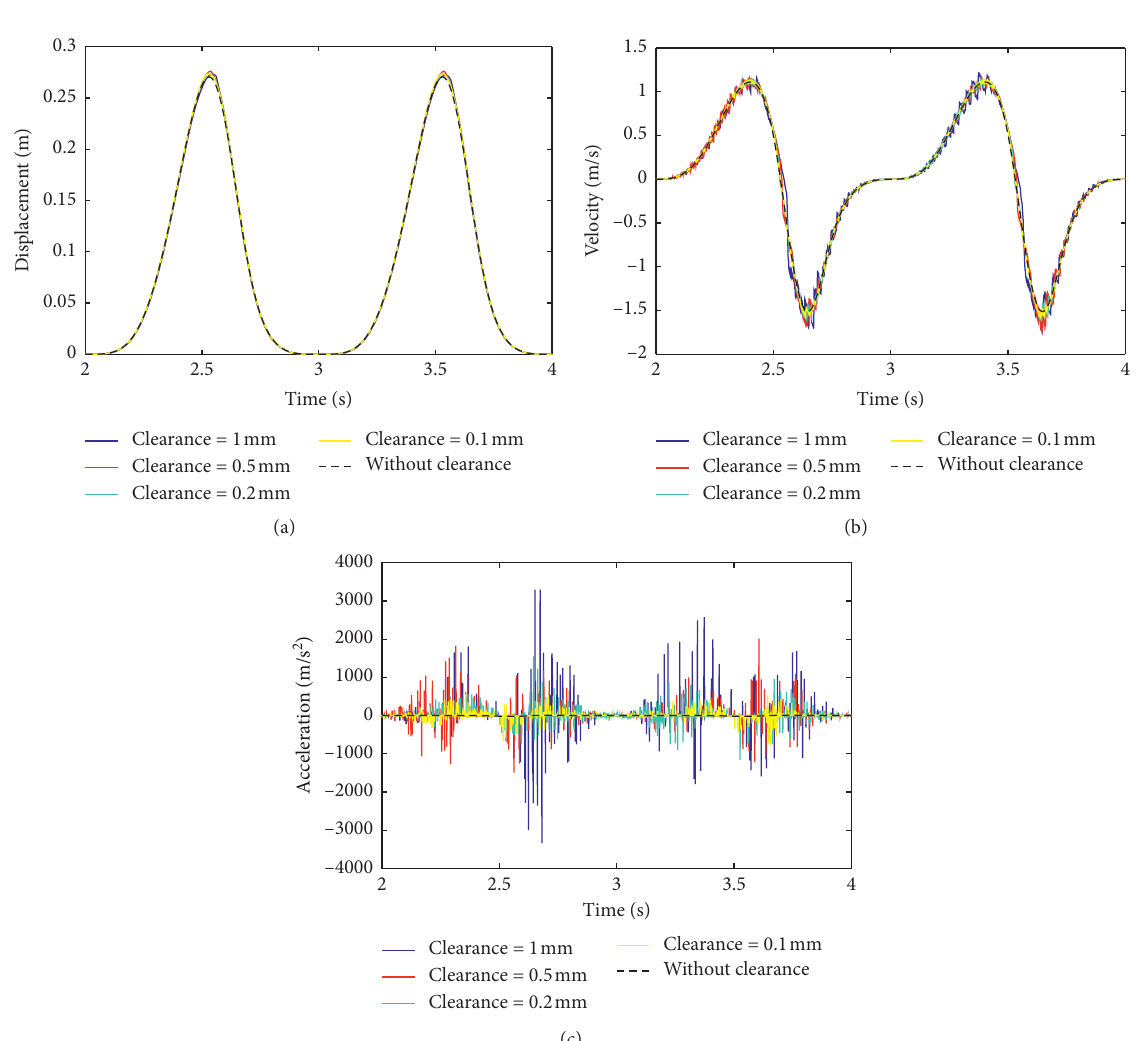
Figure 8: Kinematics characteristics of the slider. (a) Displacement of the slider. (b) Velocity of the slider. (c) Acceleration of the slider.